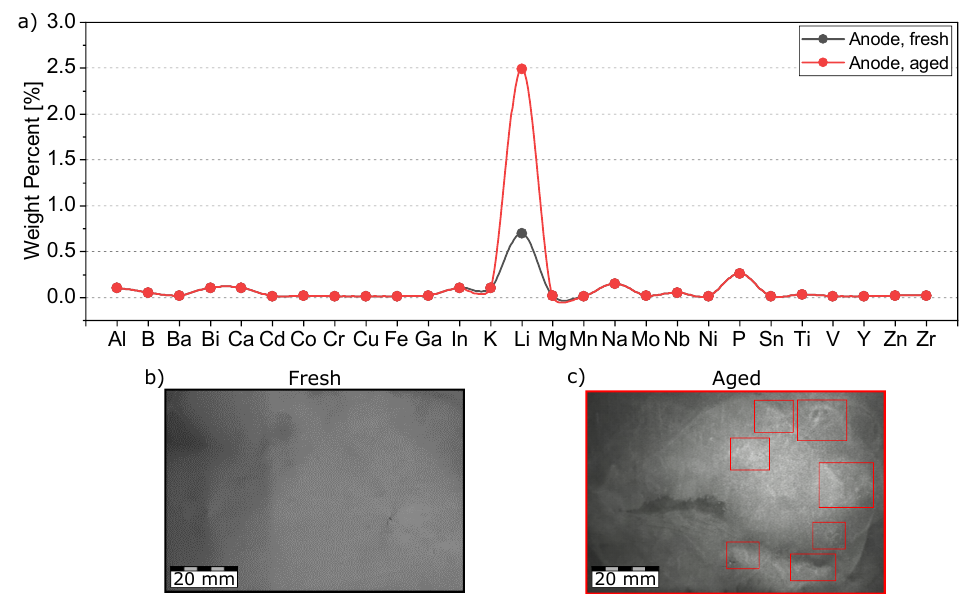
Figure 9. Lithium deposition effects for fresh and aged cells: ( a ) Shows the ICP-OES results with 355% higher lithium deposits on the aged anode surface compared to the fresh sample. ( b , c ) Show the visual comparison between fresh and aged anode samples. Significant changes of the aged anode surface in terms of white ring shaped spots, which indicate lithium plating effects, are